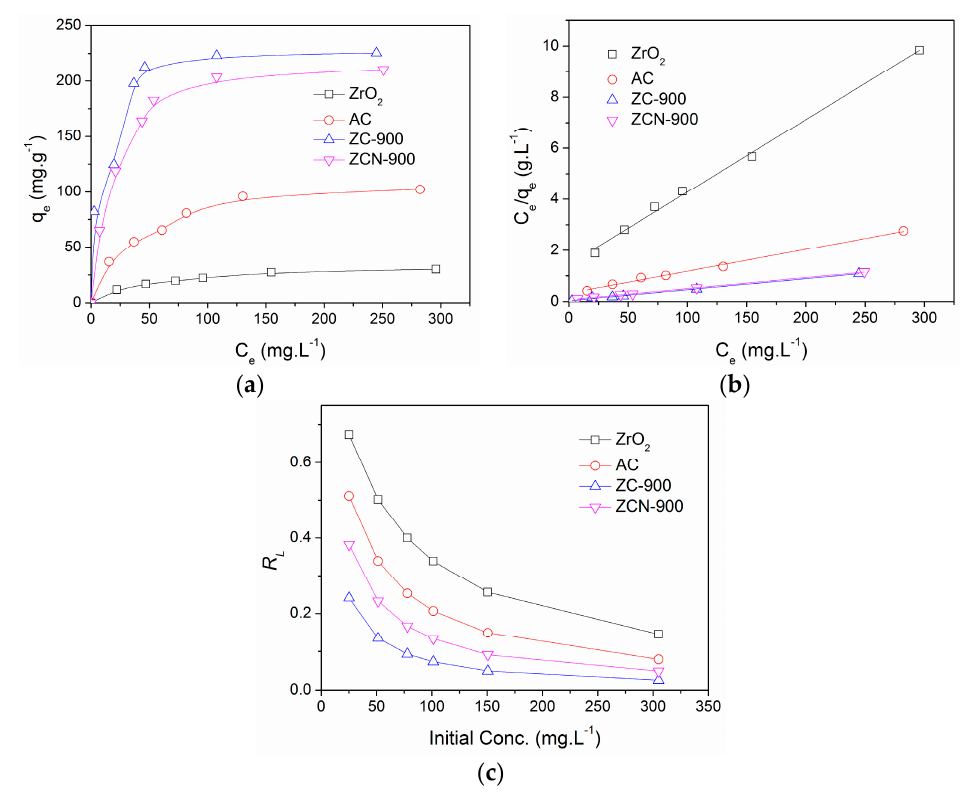
Figure 7. ( a ) Adsorption isotherms; ( b ) Langmuir plots; and ( c ) effects of initial concentrations on R L for the adsorption of CV on different adsorbents.